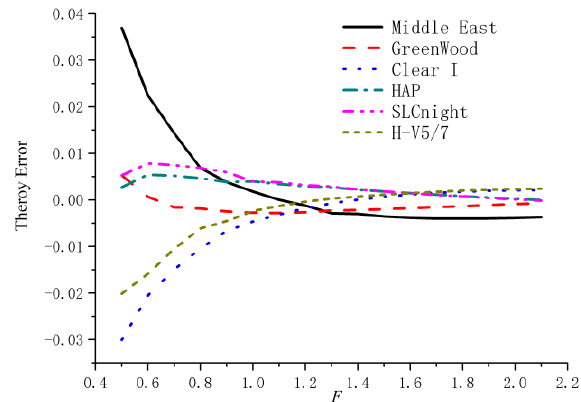
Figure 6. Theoretical error of the covariance method with different F N and various typical turbulence models when d/D = 0.53.